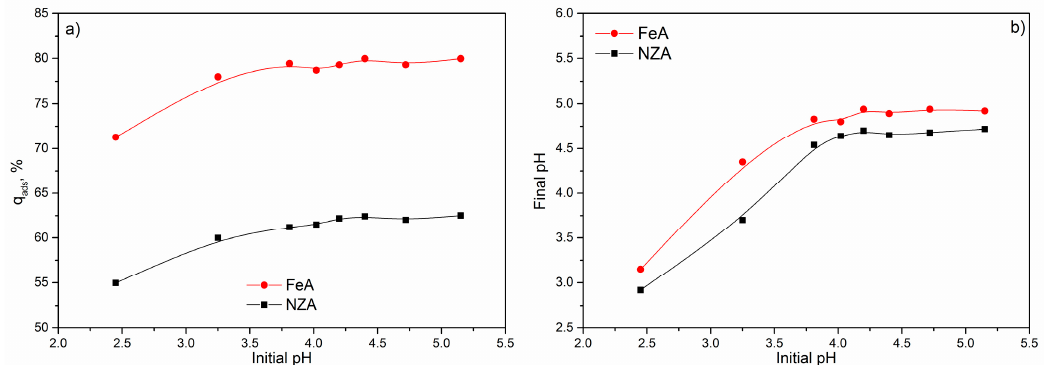
Figure 7. ( a ) Adsorbed amount of Pb 2+ as a function of pH i ; and, ( b ) pH f = f(pH i ).